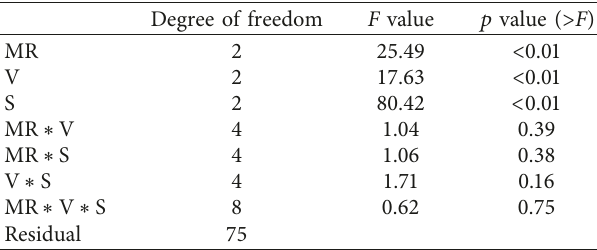
Figure 2: The change of flow velocity according to clay contents (a) and mixture volume (b) as slope condition changes. Table 2: The result of ANOVA of the flow velocity and experi- mental